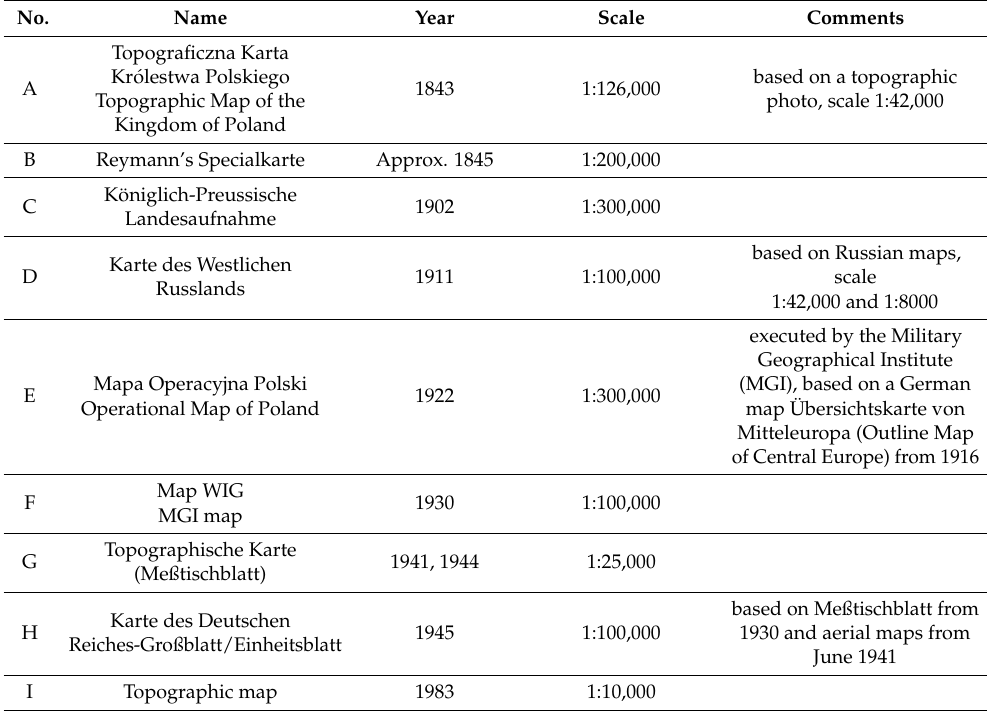
Table 1. Cartographic materials used for analysis.